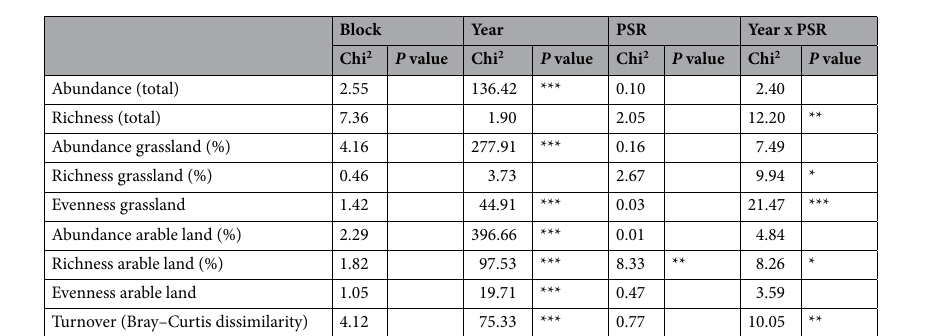
Figure 2. Numbers of ( a ) individuals (Abundance) and ( c ) species (Richness) of carabid beetles at different years and ( b ), ( d ) as affected by plant species richness. Lines in boxes represent median, top and bottom of boxes represent first and third quartiles, and whiskers represent 1.5 interquartile range. Differences among the years are assessed based on estimated marginal means. Boxes with the same letters are not statistically different. Bands in regression plots represent the level of confidence interval (0.95). Dots represent partial residuals for Year and Plant species richness.